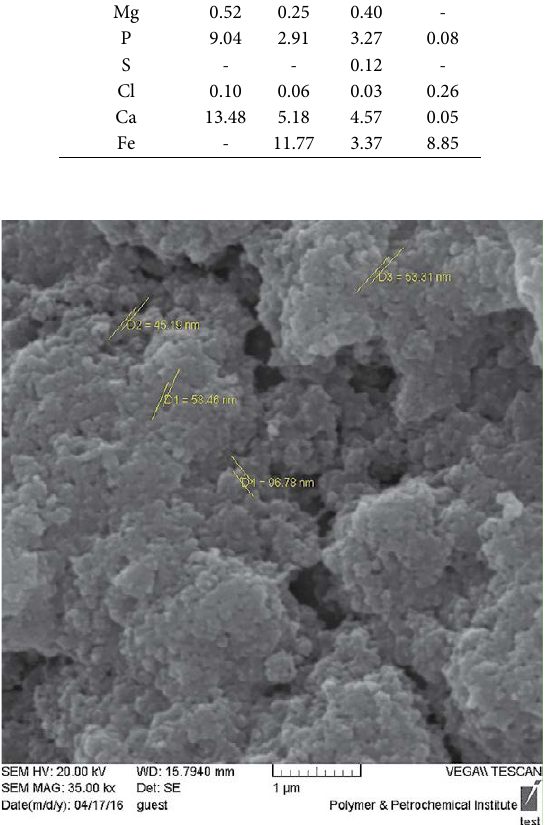
Fig. 4. Particle diameters of Fe 3 O 4 nanoparticles in FESEM image of MFS.